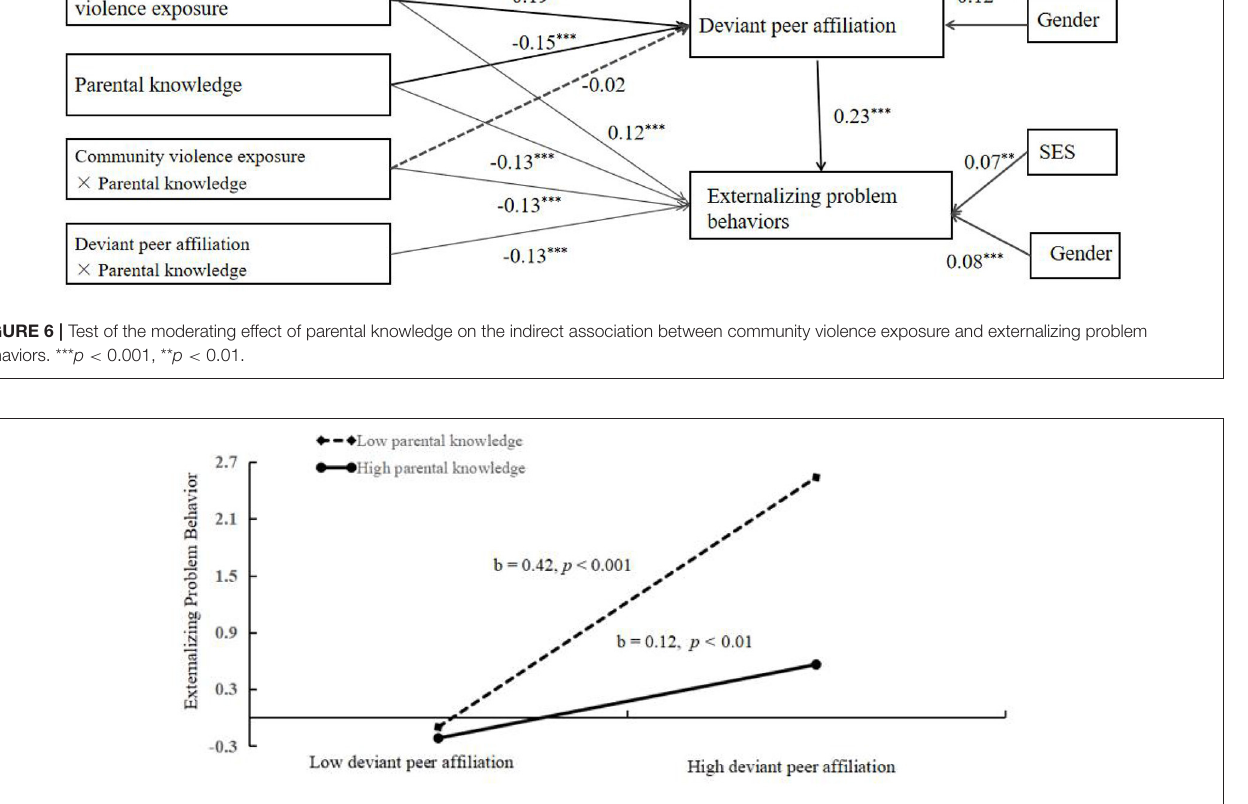
FIGURE 7 | Association between deviant peer affiliation and externalizing problem behaviors at higher and lower levels of adolescent parental knowledge (Before add covariate: school climate).